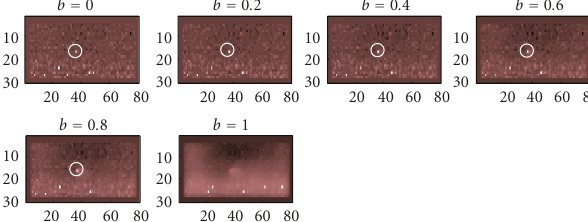
Figure 19: NA23A sequence, s n = 4, last processed frame, g = 1 case, highest 5 pixels emphasized (target pixel surrounded by a white circle) versus b .